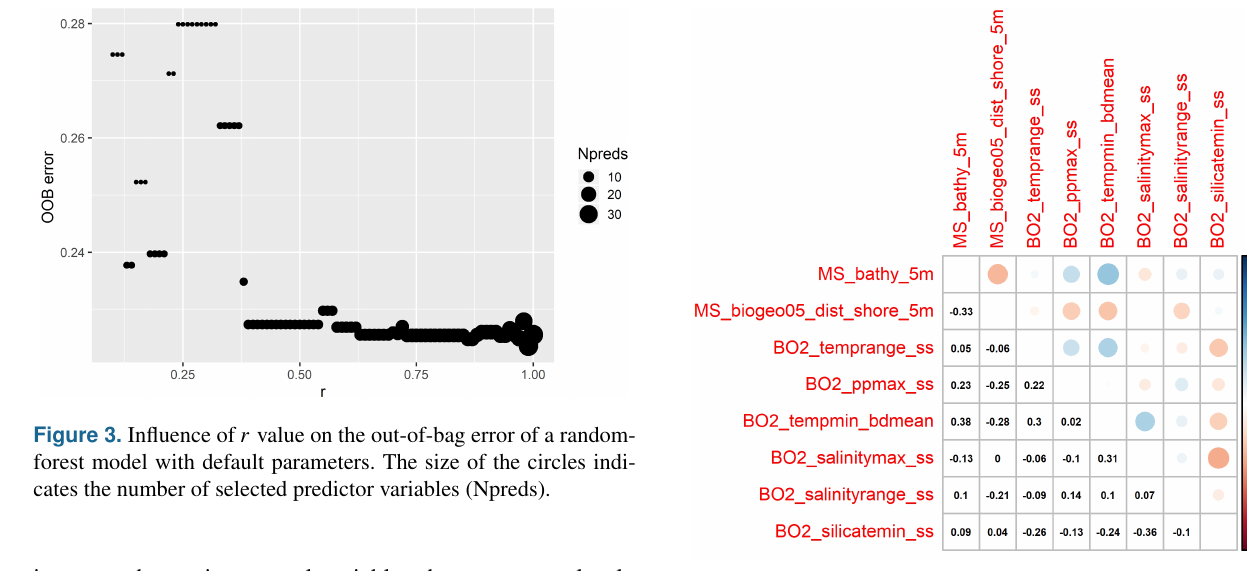
Figure 4. Correlation plot showing the correlation coefficients of the selected predictor